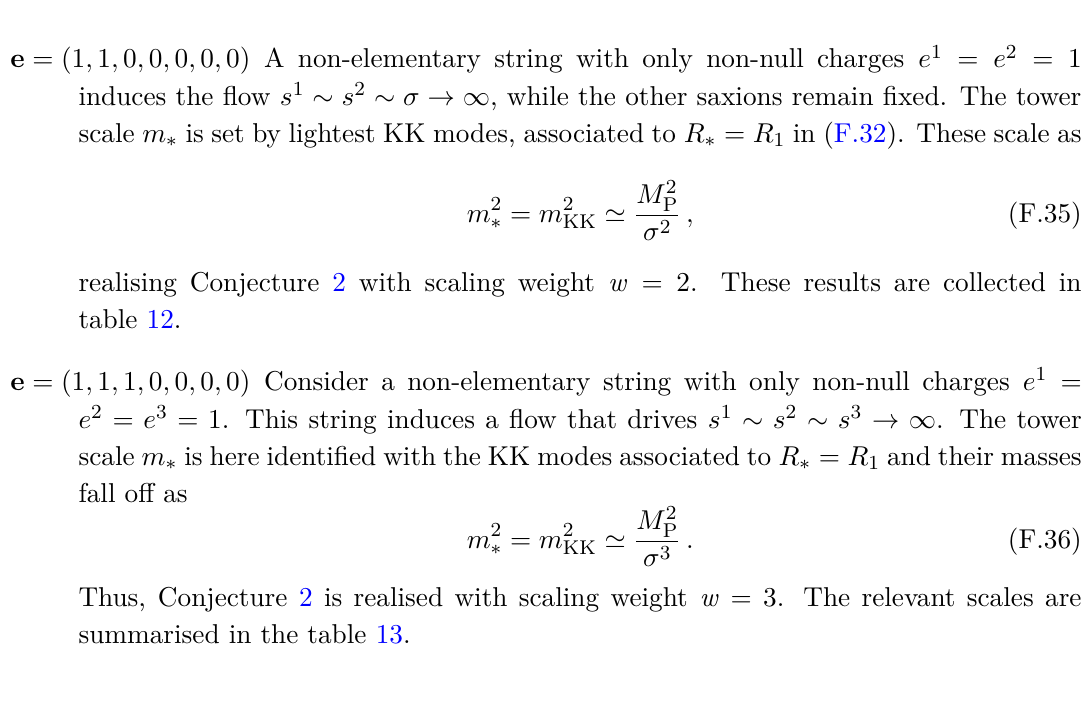
= R in (F.32). These scale ∗ 1